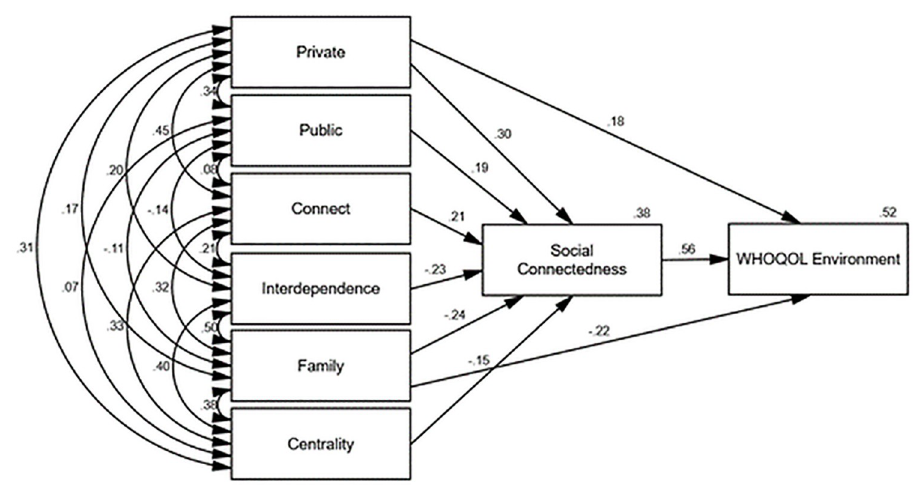
Fig 6. Final path model with standardised parameter estimates WHOQOL-Bref environment domain (transformed).